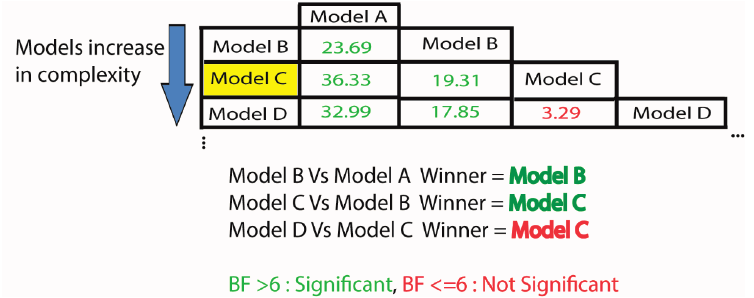
Figure 2. Overview of a sample Bayes factor analysis. Models are denoted as A, B, C and D and parameters increase from A to D ( i.e ., Model A is the least parameterized model). They are compared in a pairwise manner as denoted by the lower triangular matrix. Each pairwise comparison results in a score (or Bayes Factor) by calculating 2[lnL(Model B) − lnL(Model A)]. Significance is based on the Kass and Raftery equation [79]. Cases where